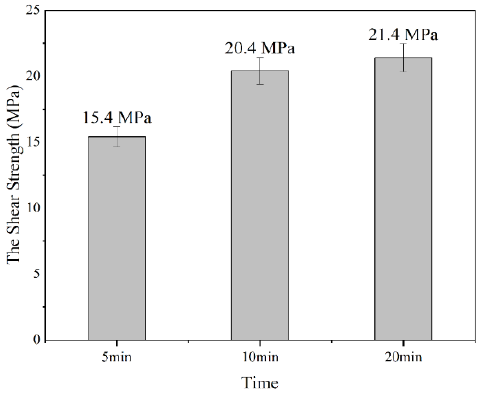
Figure 4. The shear strength at different times.